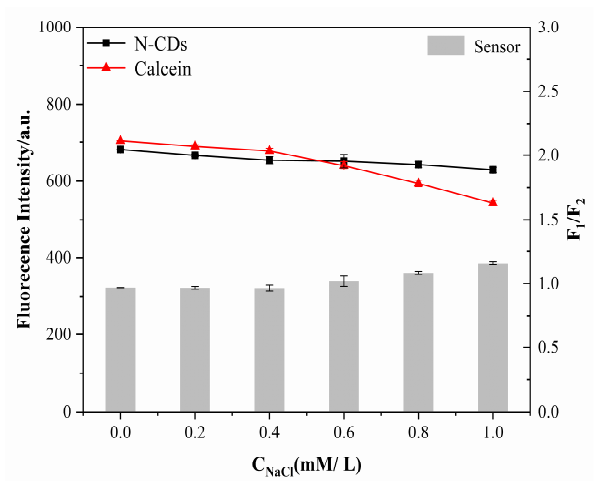
Figure 8. Effect of iconic strength on the fluorescence intensity of N-CDs, calcein and N-CD/calcein sensor.